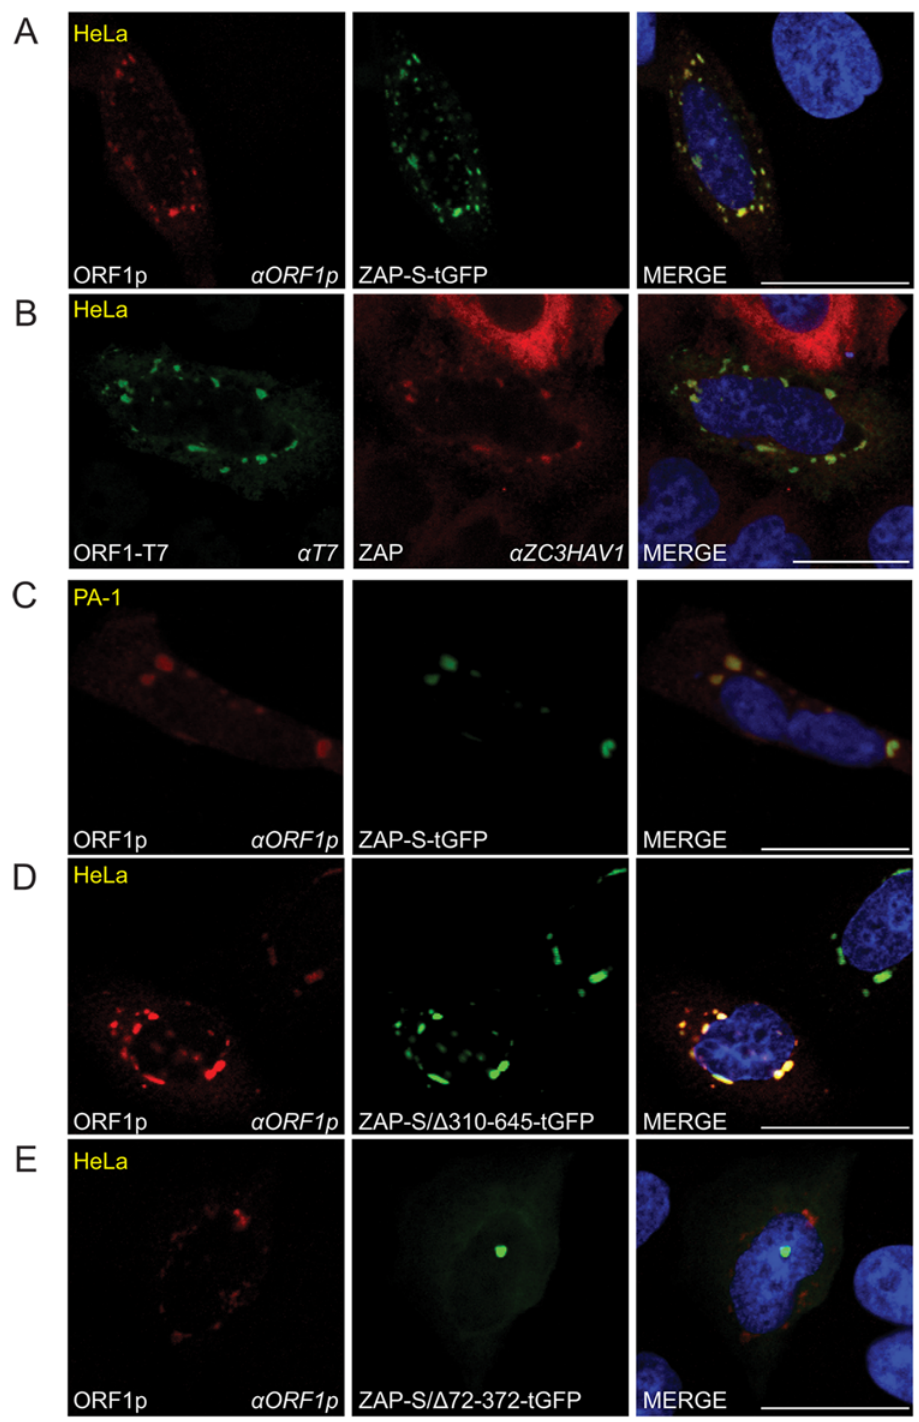
Fig 5. The co-localization of ORF1p and ZAP in cytoplasmic foci. (A) Co-localization of transfected ORF1p and ZAP-S in HeLa cells : ORF1p (red) expressed from pJM101/L1.3 Δ neo co-localizes with ZAP-S- tGFP (green). The experiment was repeated five times with similar results. (B) Co-localization of transfected ORF1p with endogenous ZAP in cytoplasmic foci in HeLa cells : ORF1p-T7 (green) expressed from pAD2TE1 co-localizes with endogenous ZAP (red). The experiment was repeated five times with similar results. (C) Co-localization of transfected ZAP-S-tGFP with endogenous ORF1p in cytoplasmic foci in